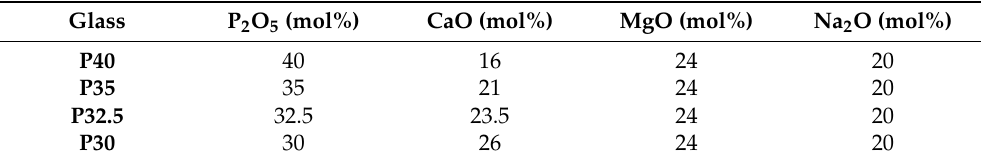
Table 1. Comparison and glass codes used for the four different phosphate glass formulations selected for microsphere preparation and